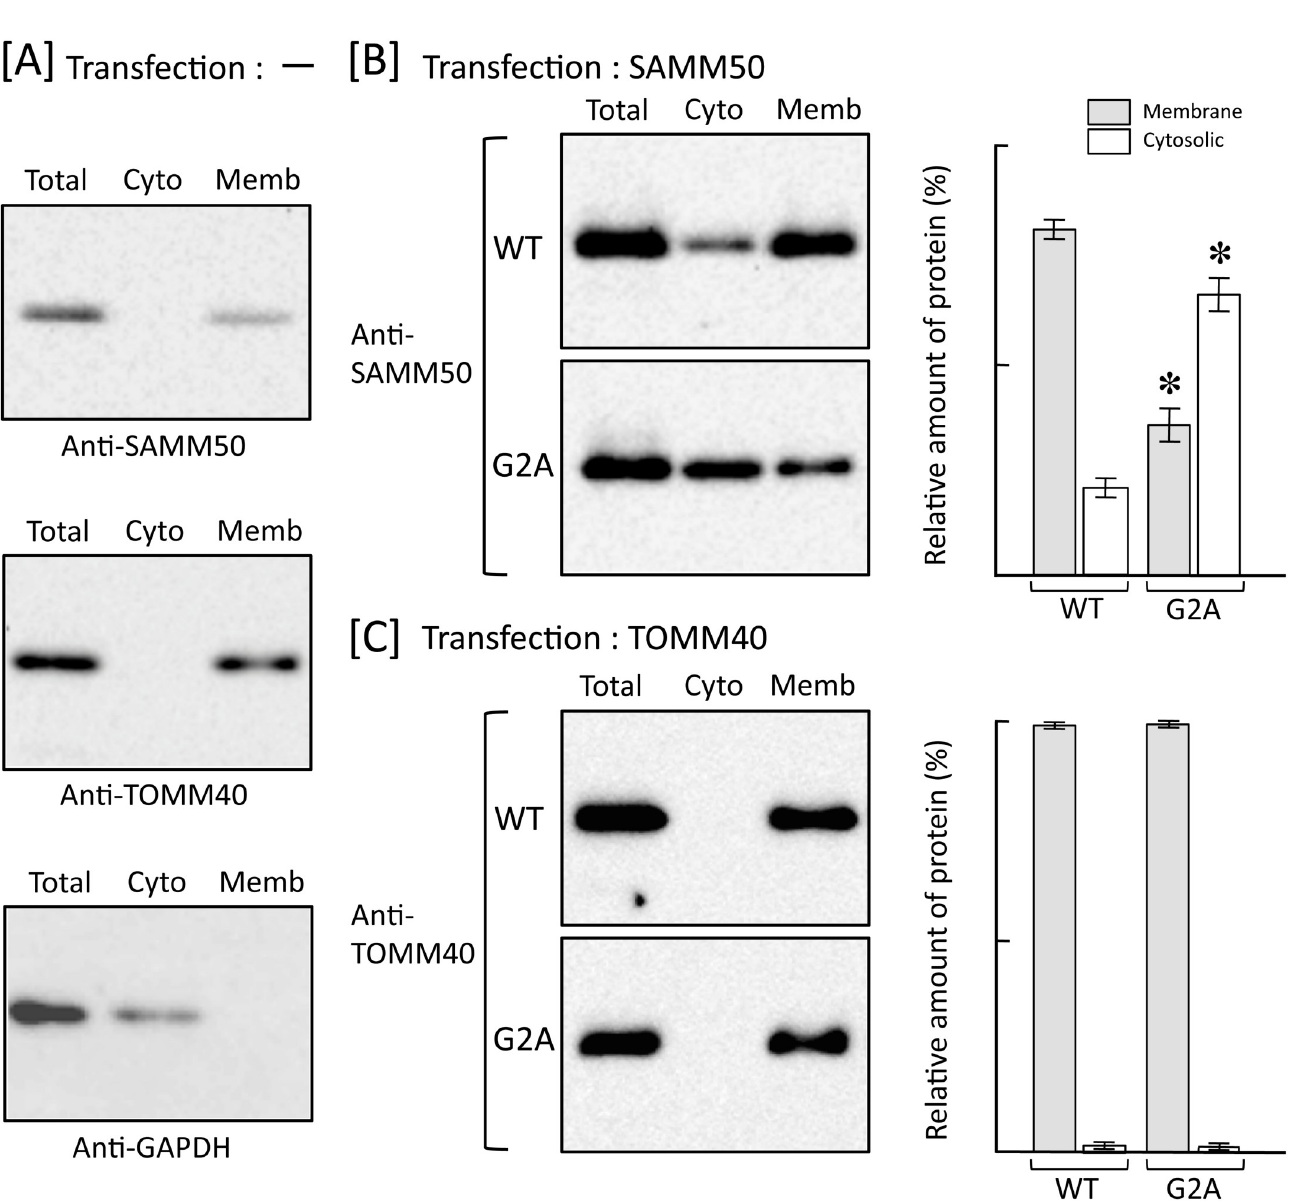
Fig 3. Protein N -myristoylation of SAMM50 but not of TOMM40 is required for binding of protein to the membrane. Total cell extracts of non-transfected COS-1 cells [A] and COS-1 cells transfected with cDNA encoding tag-free SAMM50 [B] or TOMM40 [C] were separated into cytosolic and membrane fractions by using membrane protein extraction kit (Trident). Presence of SAMM50 and TOMM40 in each fraction was determined by western blotting analysis using anti- SAMM50 or anti-TOMM40 antibody, respectively. For this analysis, anti-GAPDH antibody was used to detect GAPDH, a cytoslic marker protein [A]. For the analysis of COS-1 cells transfected with cDNAs coding for SAMM50 [B] and TOMM40 [C], relative amount of protein (%) reside in the cytosolic and total membrane fraction was calculated from densitometric analysis as described in materials and methods. Data are expressed as mean ± SD for three independent experiments. � P < 0.005 vs.